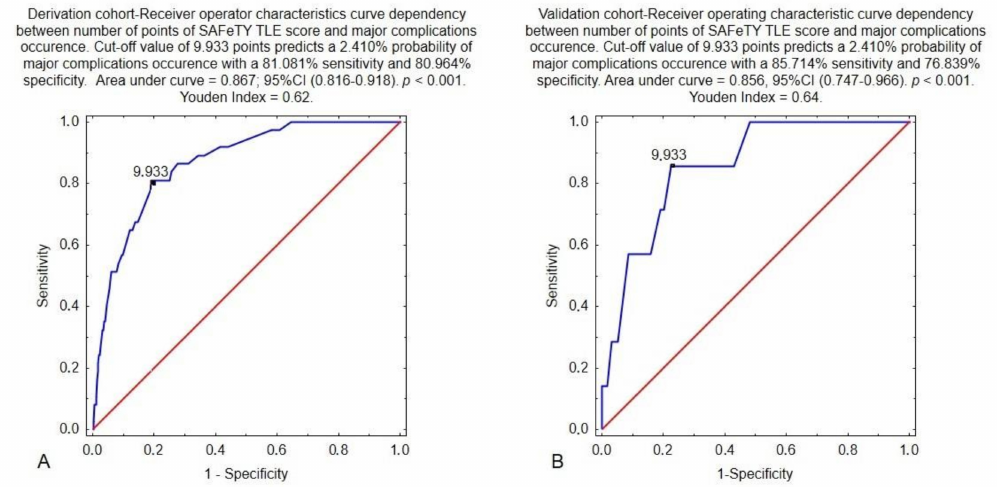
Figure 4. Derivation cohort—Receiver Operating Characteristic curve showing dependency between the number of SAFeTY TLE points and the occurrence of major complications ( A ). Validation cohort—Receiver Operating Characteristic curve showing dependency between the number of SAFeTY TLE points and the occurrence of major complications ( B